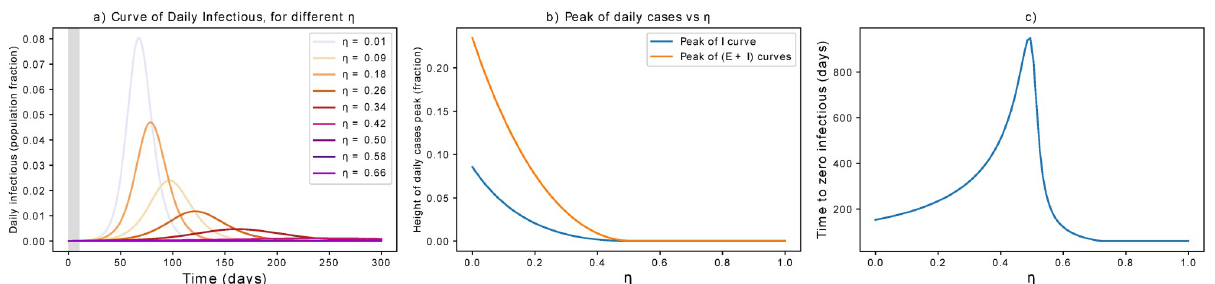
Fig 7. Dependence of infectious isolation on control parameters. (a) Effects of isolation of contagious individuals on the epidemic curve. The grey area indicates when measures are not yet in place. (b) The peak is progressively flattened until a disease-free equilibrium is reached for sufficiently large η . (c) Unless η is large enough, stronger measures of this kind might delay the mitigation of the epidemic. Note that the critical η can be higher if there is delay in intervening, i.e. if infectious individuals are isolated after several days and can thus spread the infection.